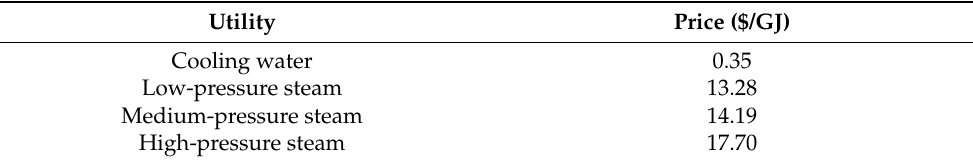
Table A1. Utility cost data